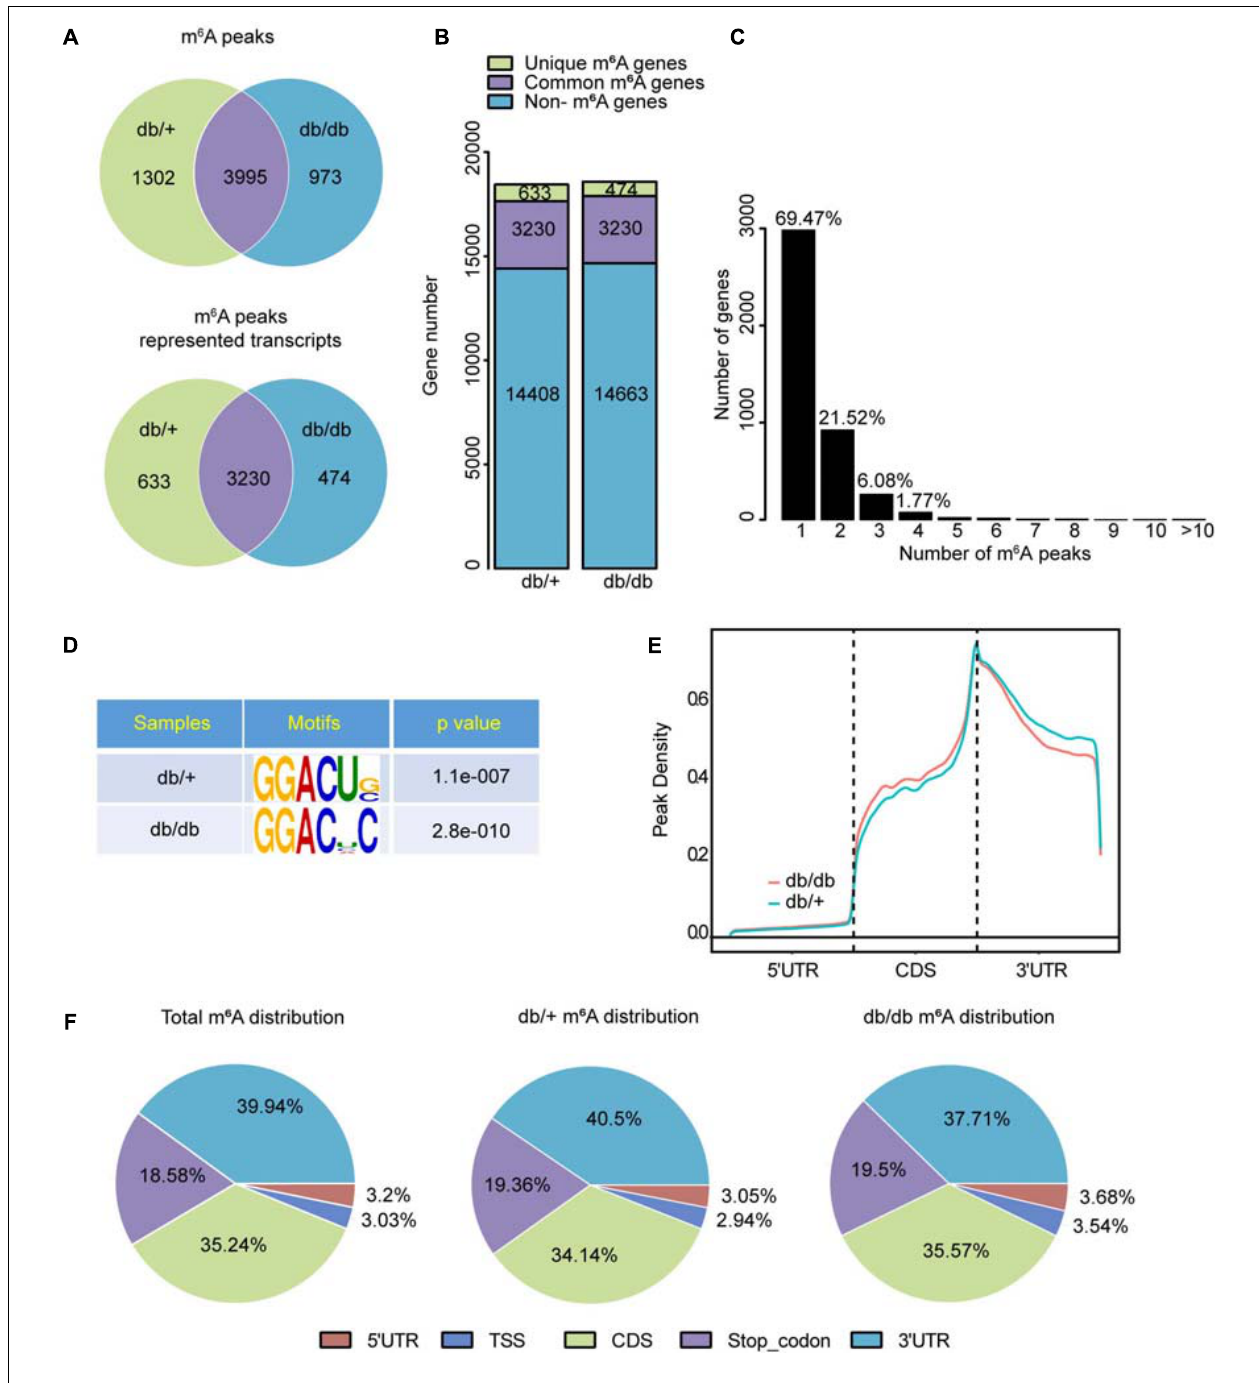
FIGURE 2 | Transcriptome-wide m 6 A-seq and analysis of m 6 A peaks. (A) Overlap of m 6 A peaks in db/ + and db/db samples. Identification of m 6 A peaks using exomePeak; numbers of DCM-unique, control-unique, and common m 6 A peaks are shown as Venn diagram of m 6 A peaks representing transcripts in the two groups. (B) Summary of m 6 A-modified genes identified in m 6 A-seq. (C) Distribution of m 6 A-modified peaks per numbers gene. (D) Top m 6 A motifs enriched from all identified m 6 A peaks in the two groups. (E) Density curve showing the accumulation of differentially methylated m 6 A peaks in transcripts for the two groups; each transcript is divided into three regions: 5 (cid:48) UTR, CDS, and 3 (cid:48) UTR. (F) Proportion of m 6 A peaks distributed in the indicated regions in the NC and DCM samples; loss of existing m 6 A peaks (NC-unique peaks) or appearance of new m 6 A peaks (DCM-unique peaks) in the DCM group.